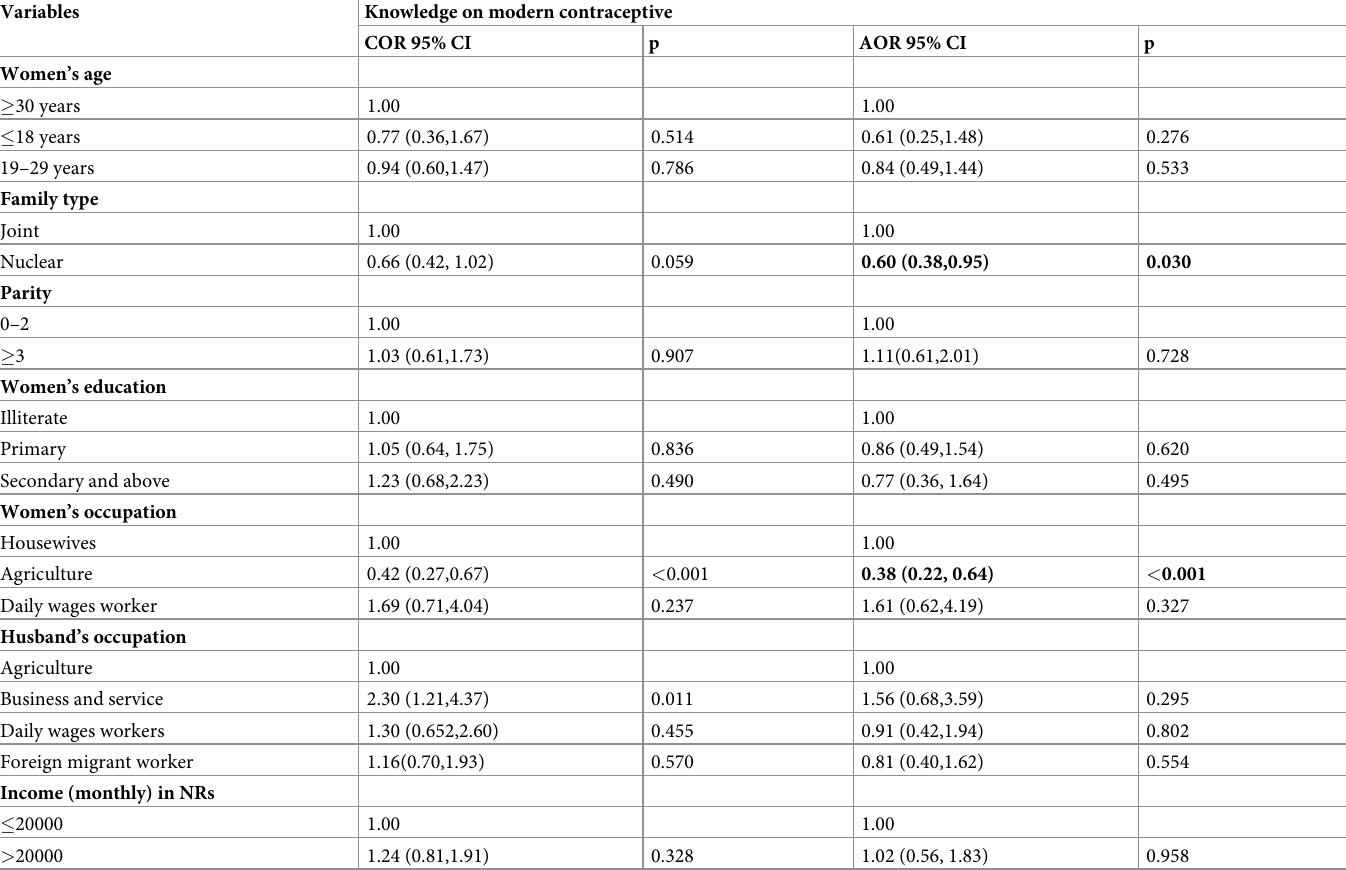
Table 4. Determinants of good knowledge on modern contraceptive methods among Nepali Muslim women (N =